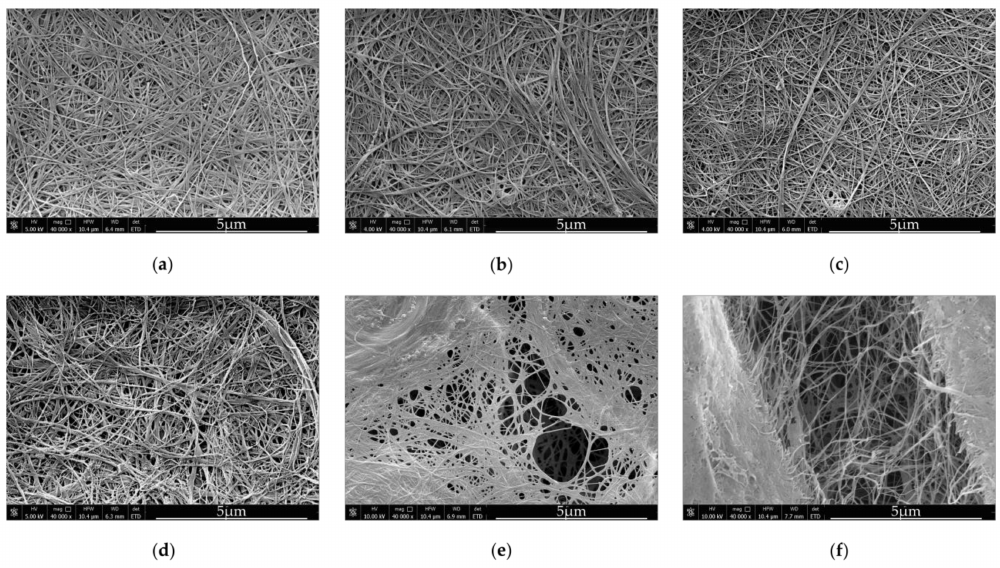
Figure 1. Scanning electron microscope (SEM) images of cellulose nanofibers in ( a ) BNC, ( b ) BNC/ κ -Car 0.2 , ( c ) BNC/ κ -Car 0.5 , ( d ) BNC/ κ -Car 0.8 , ( e ) BNC/ κ -Car 2.0 , and ( f ) BNC/ κ -Car 4.0 . The images were recorded at the magnification of 40,000 × (bar—5 µ m).